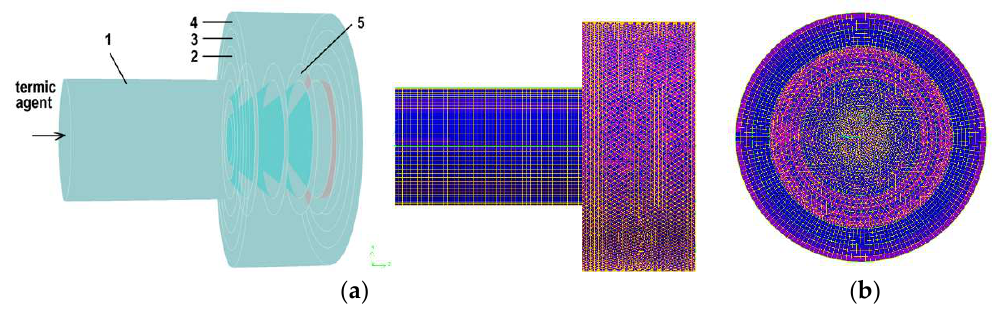
Figure 3. Cylindrical dryer meshing. ( a )—defining the control volume; 1—heat duct, 2—first seed layer, 3—second layer, 4—third layer, 5—deflectors. ( b )—cylindrical meshing.